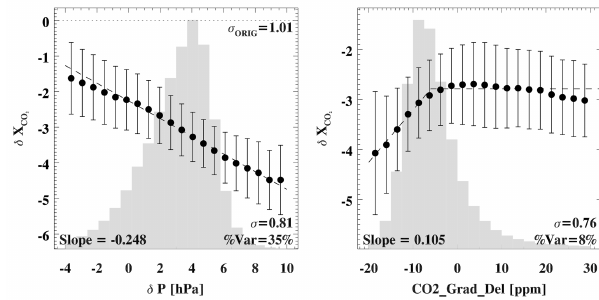
Figure 14. Same as Fig. 13 but for ocean glint measurements again using the model mean truth